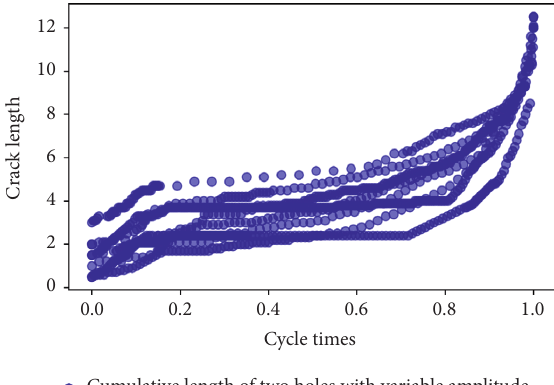
Figure 14: Cumulative length of two holes with variable amplitude.